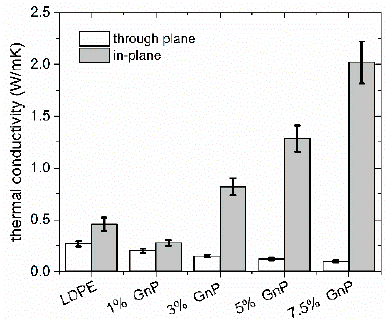
Figure 5. Thermal conductivity of nanocomposites measured in plane and trough plane direction.